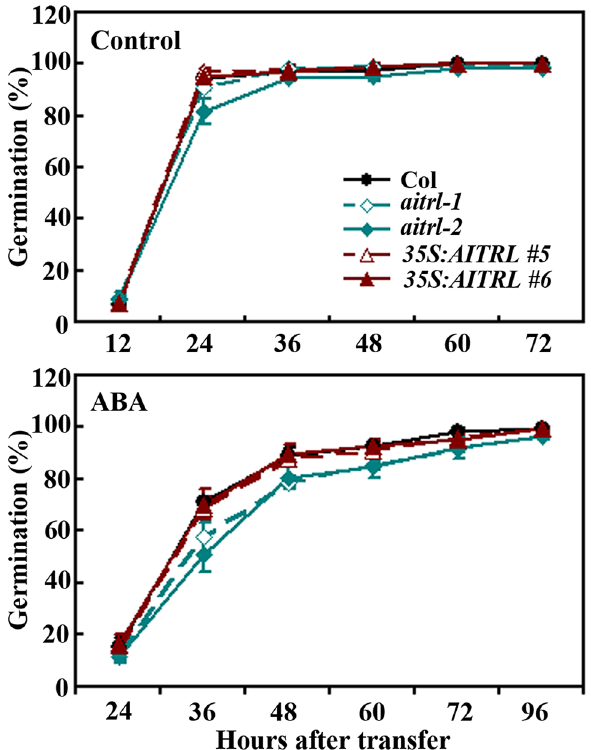
Figure 4. Effects of ABA on seed germination of the Col wild type, the 35S:AITRL transgenic plants and the aitrl mutants. Seeds of the Col wild type, the 35S:AITRL transgenic plants and the aitrl mutants were sterilized and sown on solidified 0.5 × MS salts plates in the presence or absence of 0.5 µM ABA. The plates were kept at 4 °C in darkness for 3 days before transferred to a growth room. Germinated seeds were counted every 12 h after the transfer till all the seeds were germinated, and percentage of seed germination was calculated. Data represent the mean ± SD of three replicates.